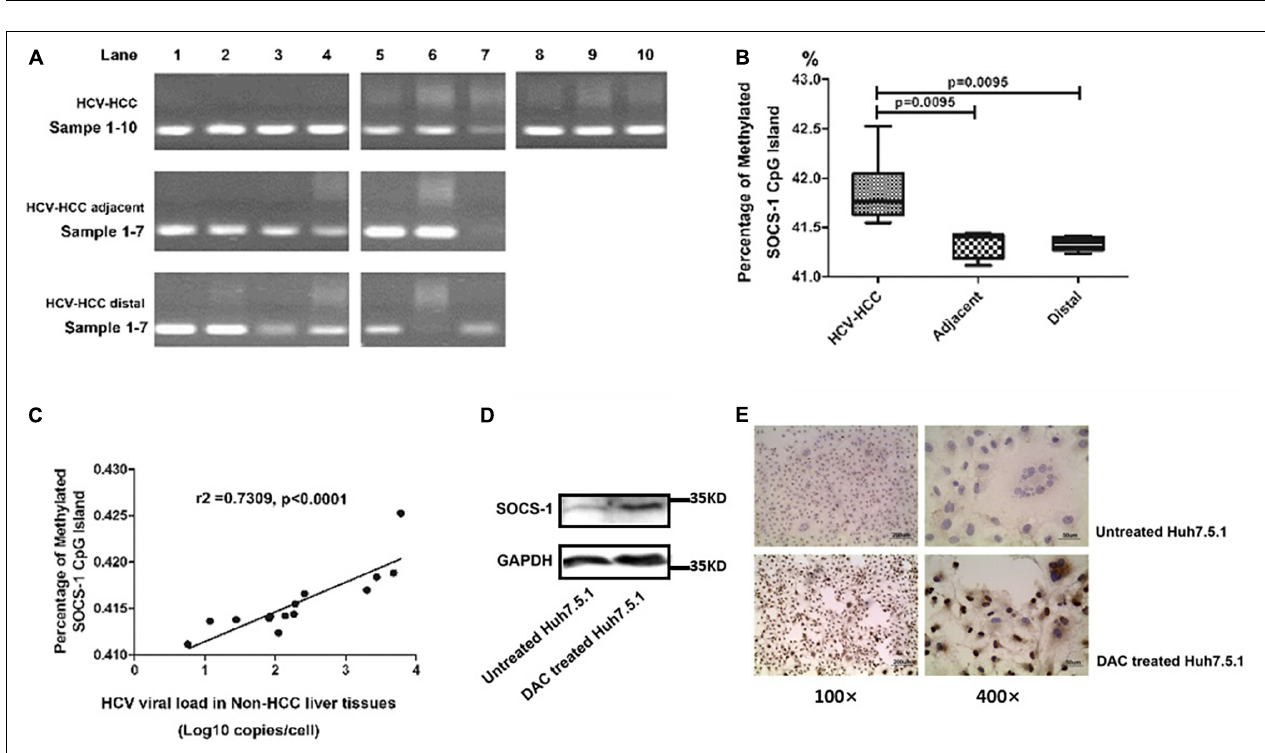
FIGURE 4 | Suppressor of cytokine signaling 1 protein and mRNA expression in Huh7.5.1 cells treated with regular cultural supernatant from other Huh7.5.1 cells (Mock) and treated with cultural supernatant containing HCVcc generated from HCV replicon JFH-1 (HCV-replicon). (A) Western blot image of SOCS-1 in cells with and without HCVcc infection. (B) SOCS-1 protein level in cells with and without HCVcc infection. (C) SOCS-1 mRNA level in cells with and without HCVcc infection (Student’s t -test).